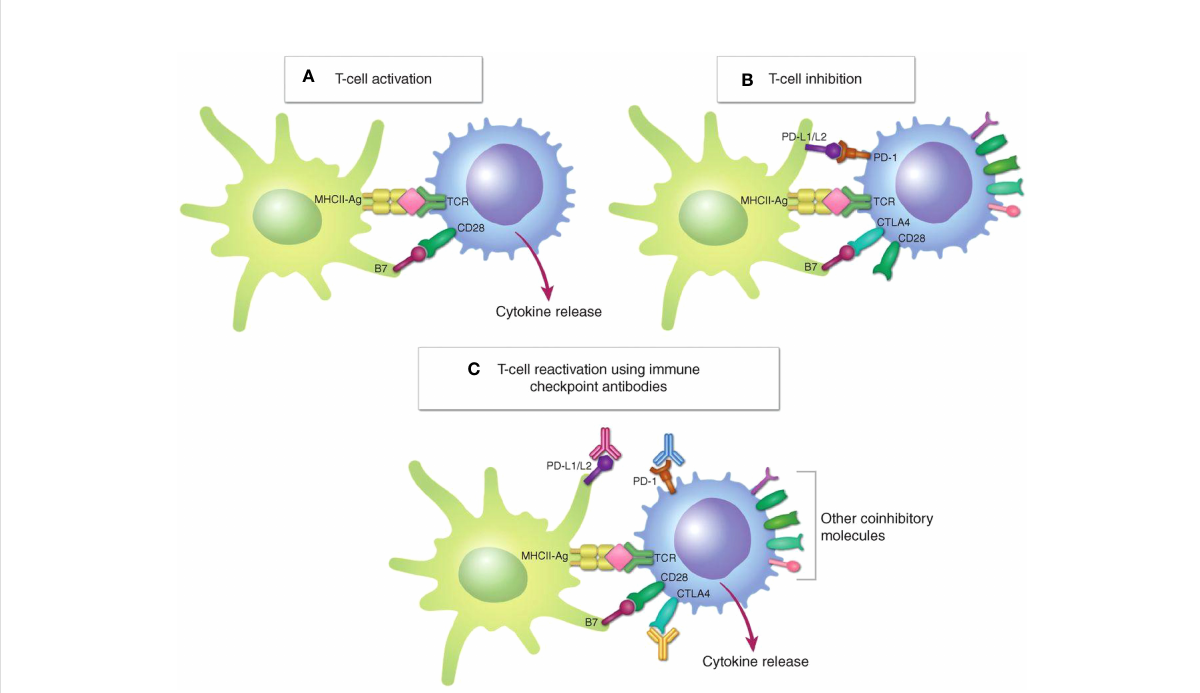
FIGURE 1 Regulation of T-cell activation. (A) , T-cell activation requires both signal 1, TCR engagement with the MHC – peptide antigen complex (MHC-Ag) on an APC or a target cell, and signal 2, interaction of the costimulatory receptor CD28 on the T cell with costimulatory B7 molecules (CD80/ CD86). (B) , In response to T-cell activation, the immune checkpoints CTLA4 and PD-1 are upregulated on the T cell and bind to B7 and PD-L1/ L2, respectively, to inhibit T-cell activation. (C) , Immune checkpoint antibodies targeting CTLA4 or PD-1/PD-L1 block these inhibitory interactions, reactivating T cells (14). Copyright © 2021, American Association for Cancer Research